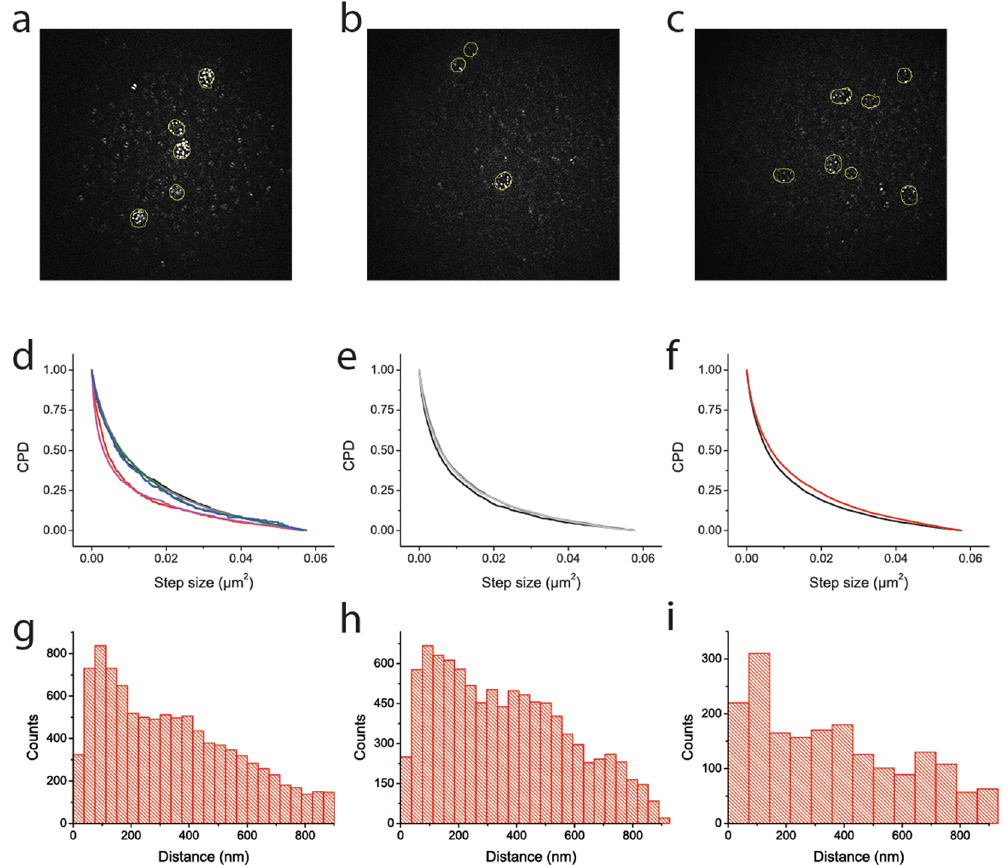
Figure 4. Comparison of S. cerevisiae cells immobilized by the ConA and the APTES-glutaraldehyde methods. Panels a–c show fluorescence background on the slides immobilized with ConA ( a ), glutaraldehyde ( b ) and EM-grade glutaraldehyde ( c ). A discoidal averaging filter (inner radius of 1, outer radius of 3 pixels; same as during the data analysis) was used on the images. Panels d–f show the cumulative probability distribution of step sizes of Can1-mCardinal molecules immobilized with ConA ( d) ; 6 independent experiments) or APTES- glutaraldehyde ( e ); 3 independent experiments). Panel f shows the cumulative probability distribution of all step sizes of Can1 in cells immobilized with ConA (red) or glutaraldehyde (black). Panels g–i show the distance distribution of localized molecules of Can1 to the center of the nearest eisosomes in cells. Panel g and h show the distribution of all Can1 found in cells immobilized with ConA ( g ) or APTES-glutaraldehyde ( h ). Panel i shows the sum of the molecules from the two independent experiments that have a much higher immobile population (red and pink lines on panel